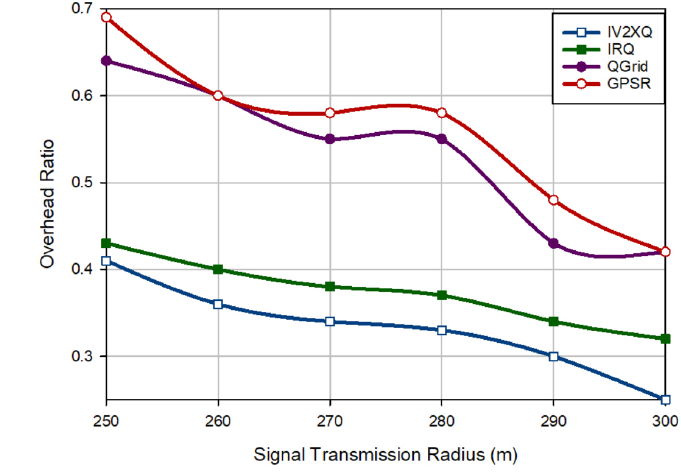
Figure 11. Comparison of routing overhead in different methods based on